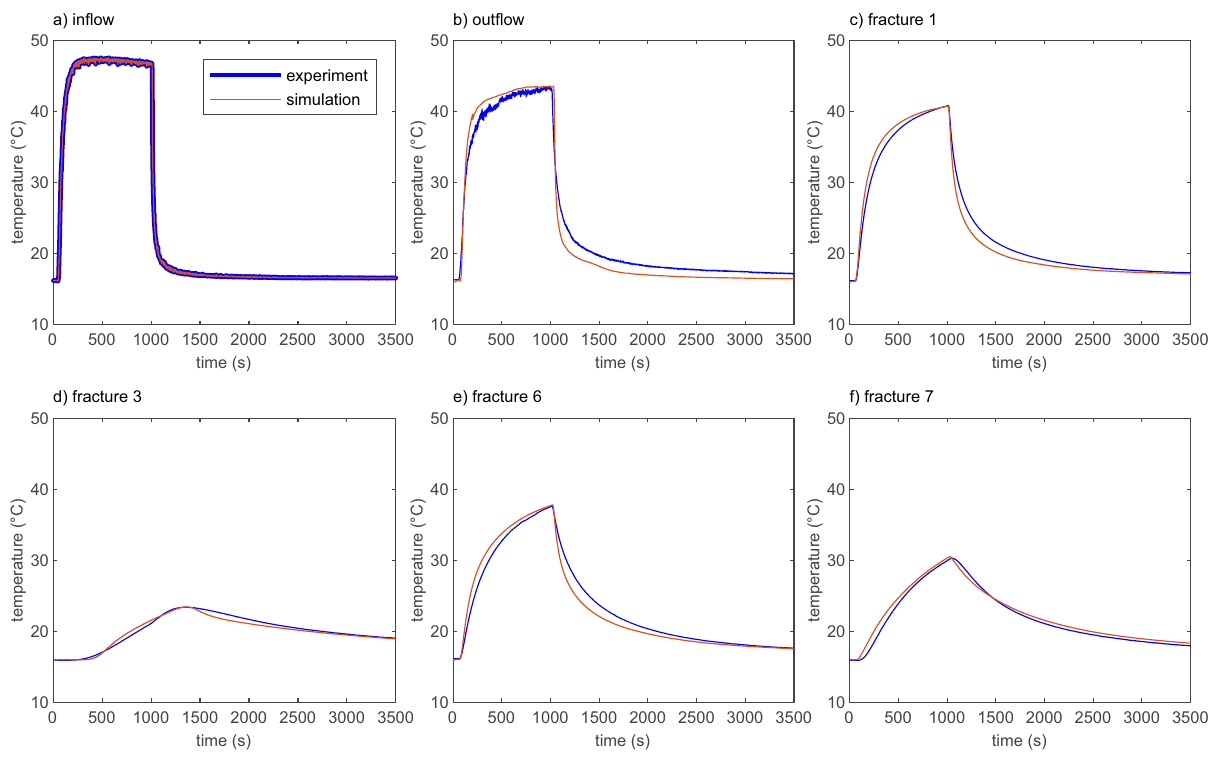
Fig. 2 | Thermal breakthrough curves. Water temperature at in- ( a ) and out fl ow ( b ) and rock temperatures recorded in the middle of fracture 1 ( c ), fracture 3 ( d ), fracture 6 ( e ), and fracture 7 ( f ) for a fl ow rate of 7.9×10 − 6 m 3 /s during the